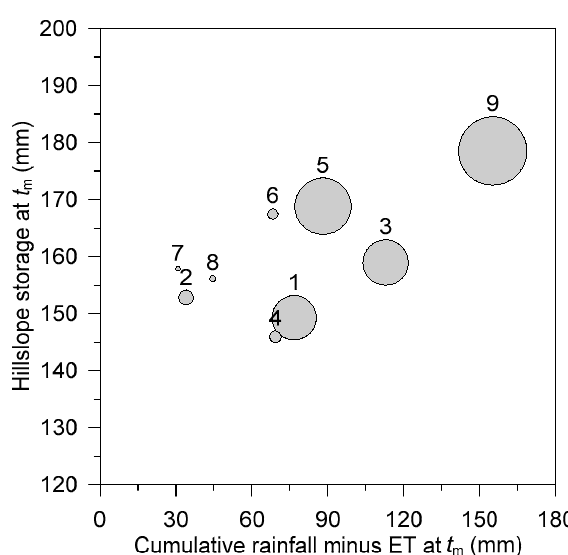
Figure 5. The relationships between net water input (rainfall minus transpiration), hillslope storage and stormflow median travel times, t m , for the selected rainfall–runoff episodes. The circles are labeled with the episode numbers. The magnitude of the respective median travel time (cf. Table 2) is expressed by the circle diameter.